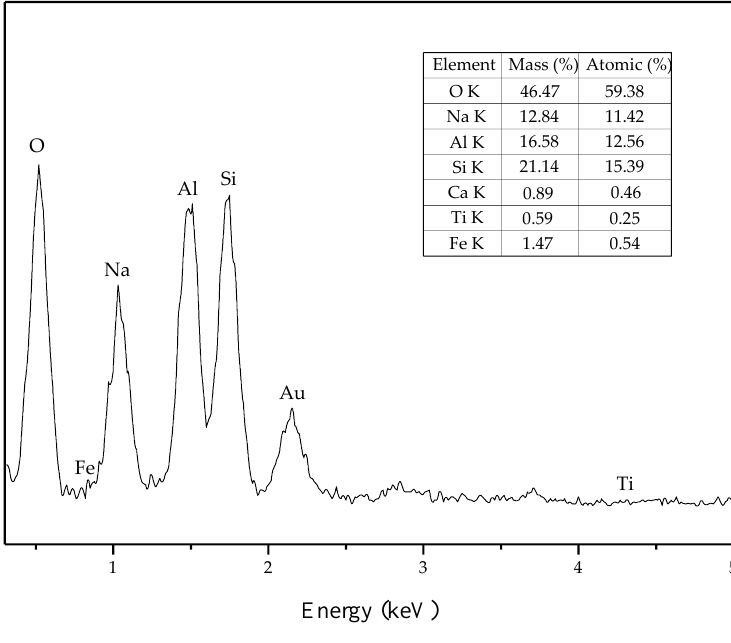
Figure 8. Energy dispersive X-ray (EDX) spectrum of No. 20.